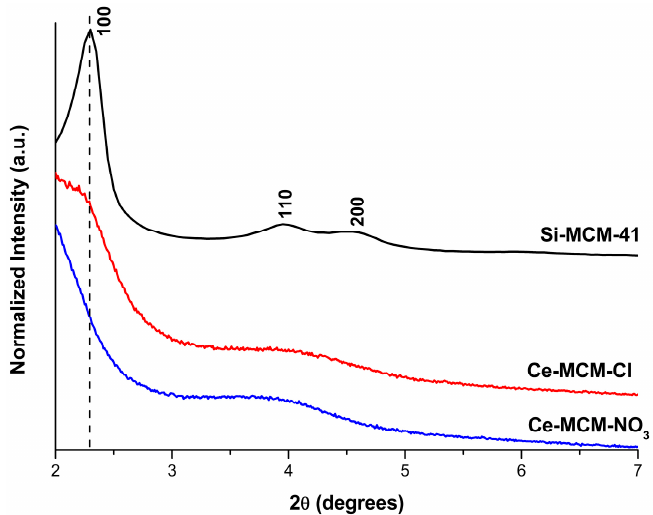
Figure 1. XRD patterns of the calcined MCM-41 materials at the low angle region.